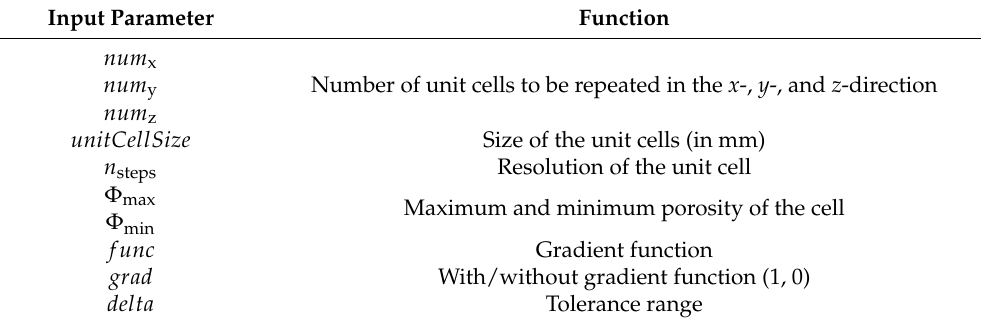
Table 1. Input parameters of the MatLab program and their function for the creation of a gyroid